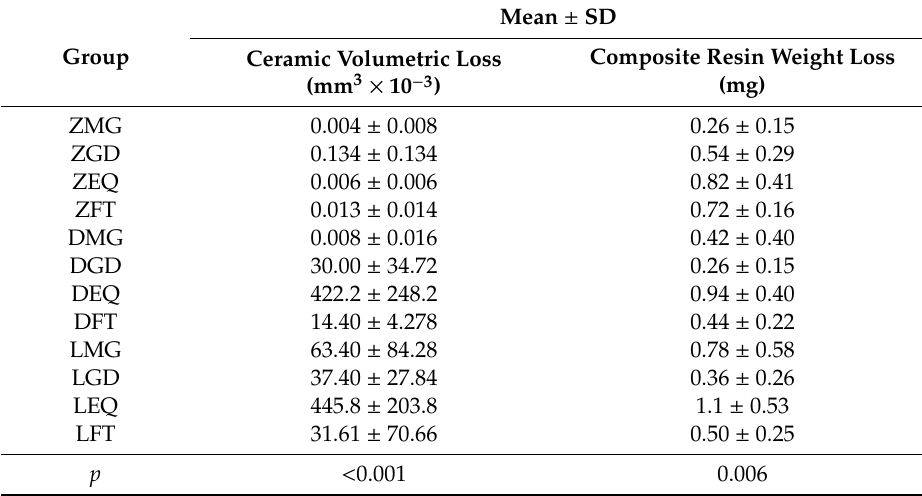
Table 3. Means ± standard deviations (SD) of volumetric losses of dental ceramic teeth and weight losses of dental composite resins after wear test.